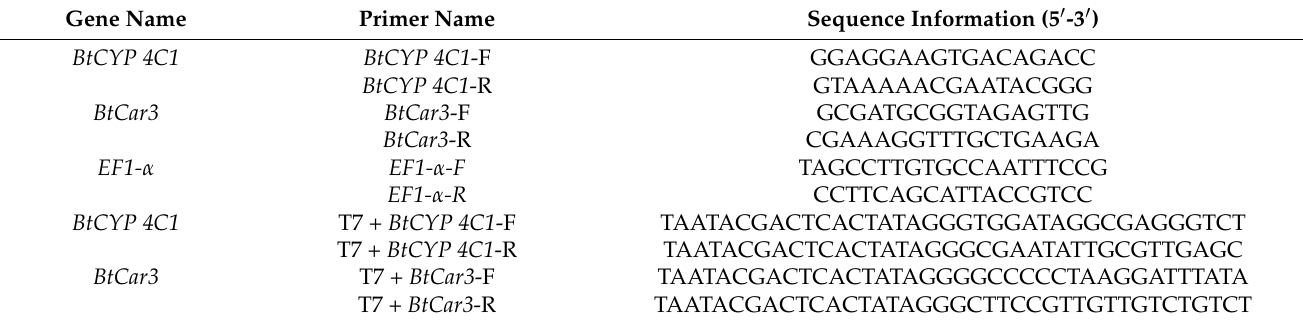
Table 1. Primer sequences of BtCYP 4C1 , BtCar3 and reference gene and the T7 primer sequences used to generate dsRNA in Bemisia tabaci